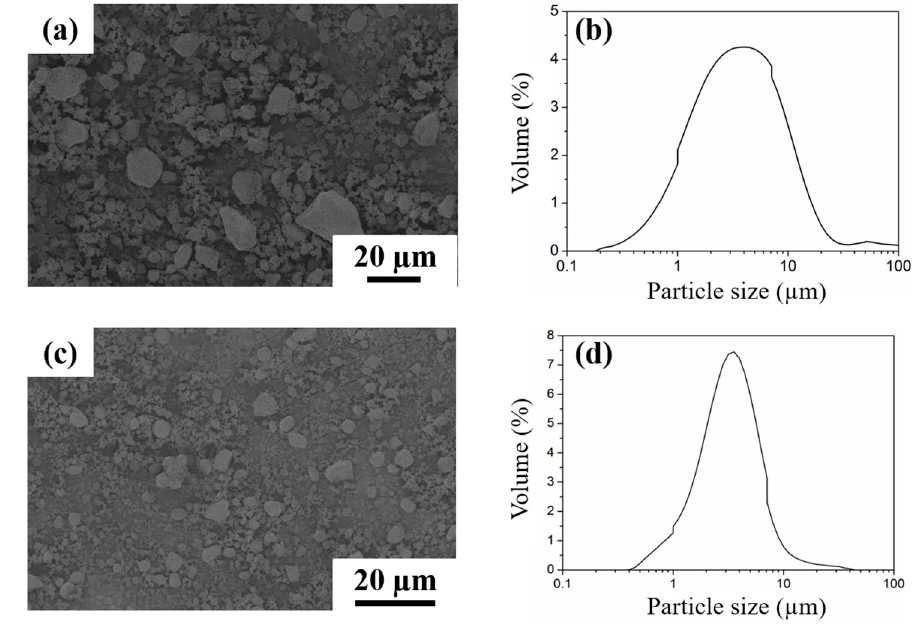
Figure 2. FESEM micrograph of Al 2 O 3 -10TiC powder with 3 wt. % Nb addition in ( a ) un-milled and ( c ) milled conditions along with their particle size distribution ( b , d ), respectively.